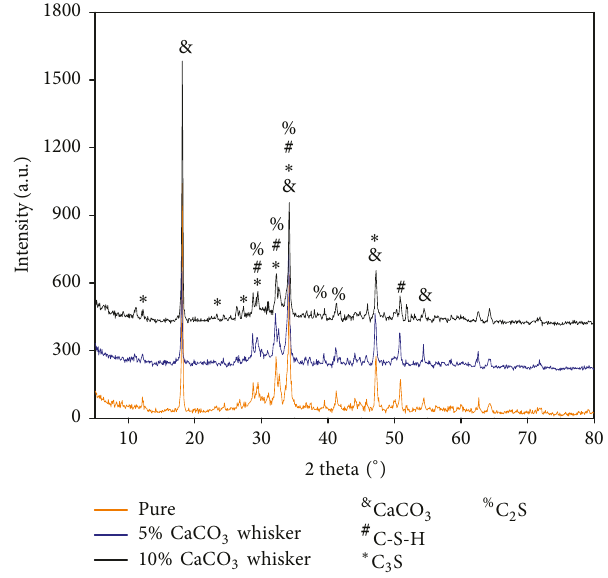
Figure 22: The XRD results of CaCO 3 whisker reinforce cement